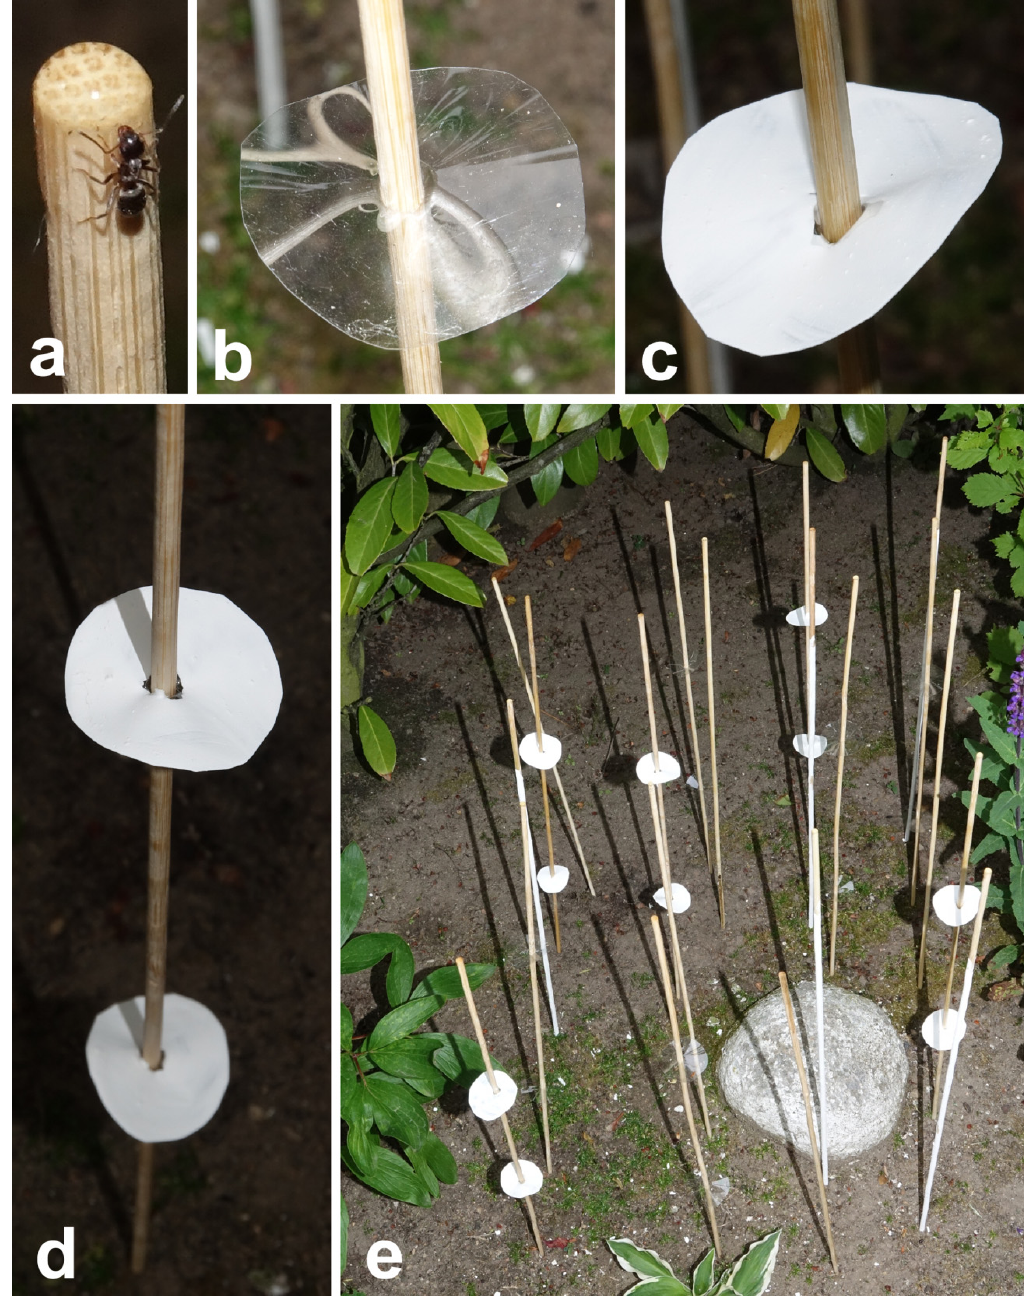
Figure 2. Set-up for the experiment with ants. ( a ) An ant feeding on a sweet droplet deposited on the stick tip. ( b ) Transparent cuff made out of transparent polyester film. ( c ) The cuff bearing calcium carbonate coverage that mimics an epicuticular plant wax. ( d ) Two cuffs places on a stick sample. ( e ) Arrangement of test sticks at the study site.